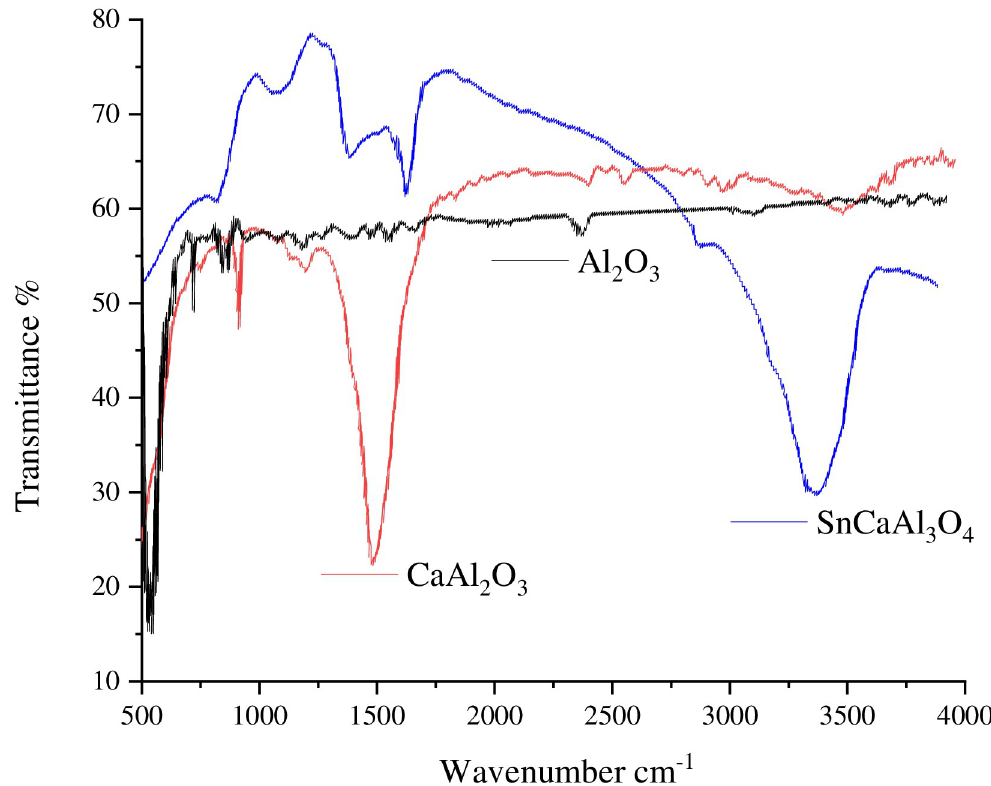
Fig 1. FTIR of Al 2 O 3 , CaAl 2 O 3, and SnCaAl 2 O 3